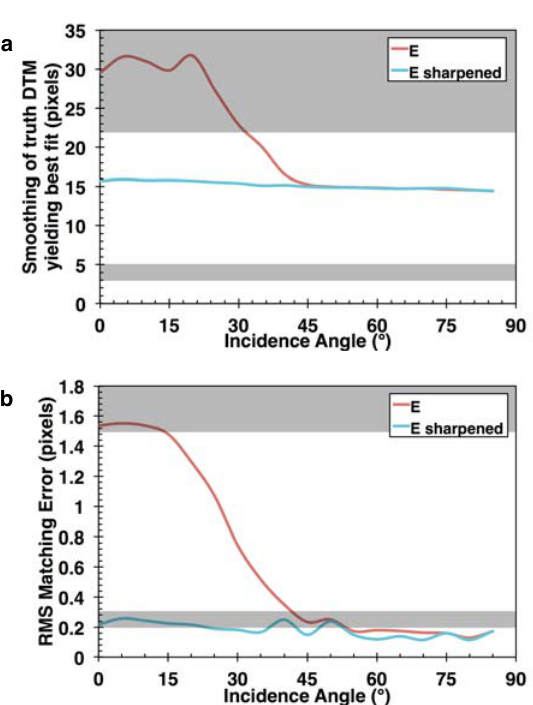
Figure 6. Plots of (a) horizontal resolution and (b) matching precision as a function of incidence angle. Red curves are for illumination from the east, as shown in Fig. 3. Blue curves are for images pairs generated identically but with an albedo map enhanced with pixel-scale details (Fig. 5, right).